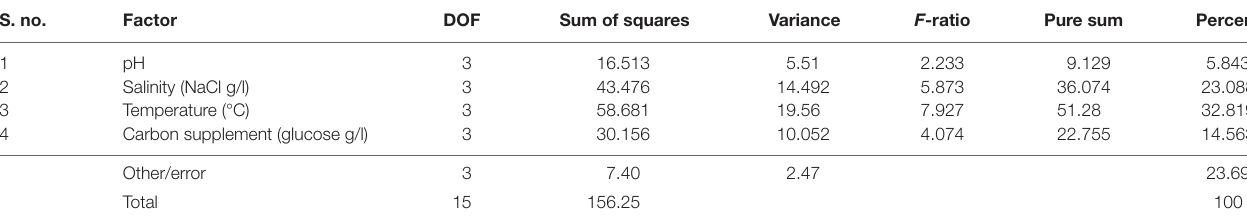
TaBle 8 | analysis of variance analysis (anOVa) for neutral lipids synthesis. s. no.